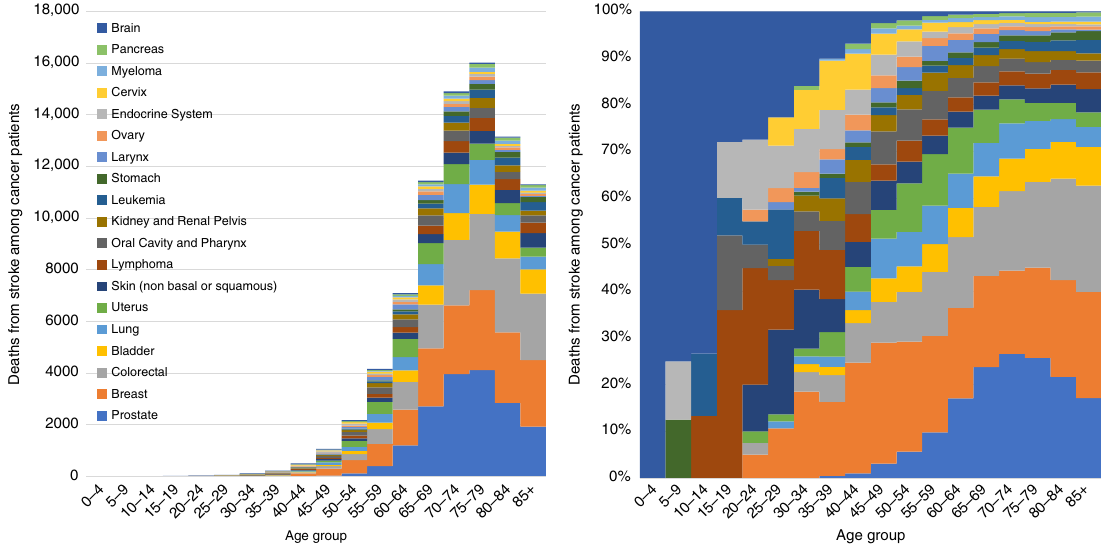
Fig. 3 Fatal stroke among cancer patients as a function of age group. a The y -axis depicts the absolute number of strokes and the x -axis depicts the age group at time of diagnosis. The colors depict the disease sites. The majority of strokes are in patients diagnosed at an older age (i.e., 40 – 90-year-olds), and the plurality of strokes s occurs in patients diagnosed with prostate, breast, and colorectal cancer. b The y -axis depicts the relative number of strokes compared to all cancer patients, and the x -axis depicts the age group at time of diagnosis. The colors depict the disease sites. For children, adolescents, and young adults (i.e., <40 years old), the plurality of strokes is seen in brain tumor patients. In contrast, among older adults (i.e., >40 years old) the plurality of strokes occurs in patients with cancer of the prostate, breast, and colorectal cancer. Source data are provided as a Source Data fi